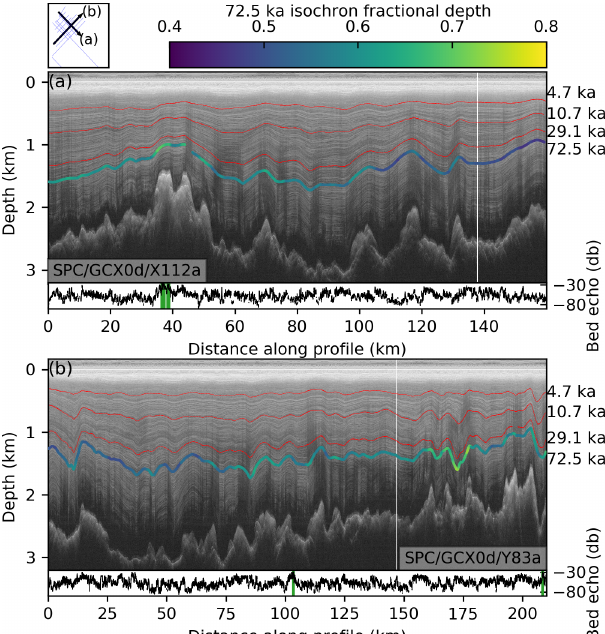
Figure 7. Example radargrams with traced IRH. A context map is in the upper left corner. Beneath each panel is the bed echo strength, which when it exceeds − 30dB is highlighted with vertical green lines, the same regions highlighted in Fig. 5. The white vertical line on each radargram represents the intersection of the two transects. Figure 8. Dated IRH depth and submergence. Panel (a) is the frac-